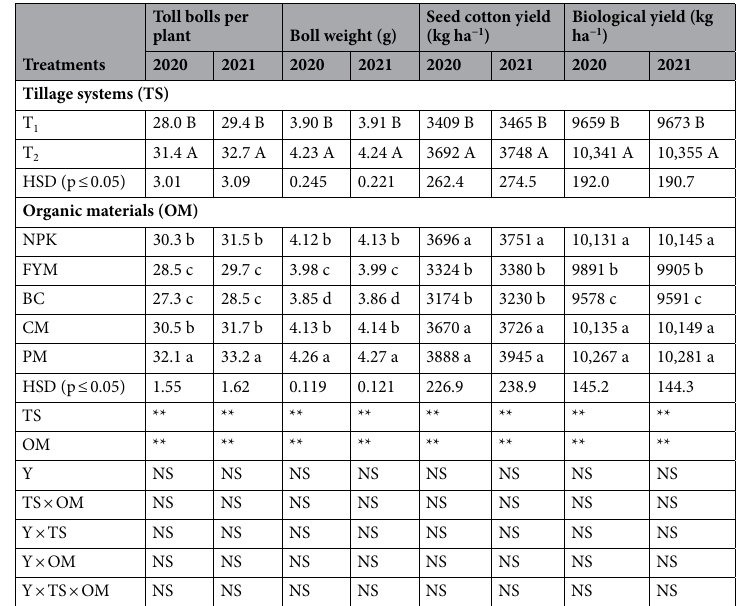
Table 3. Effect of different tillage systems and organic materials on the yield attributes of cotton crop. Values sharing the same alphabet letters did not differ markedly at p ≤ 0.05 for a particular trait. NS non-significant